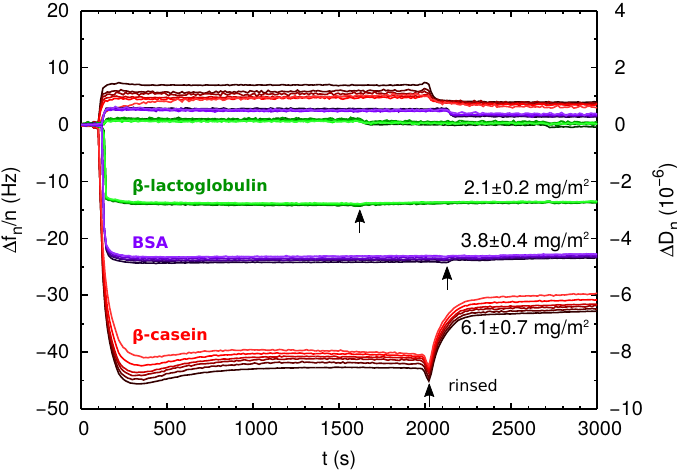
Figure 4. QCM-D measurements for direct adsorption experiments of proteins onto negatively-charged PS hydrophobic surfaces. The curves labeled with the protein names correspond to the changes in resonance frequency ∆ f n / n of the QCM crystal as a function of time due to the addition of 1 mg/mL protein solution. We also show the energy dissipation ∆ D n measured during the same experiments (unlabeled curves). Black arrows indicate the time at which the crystal is rinsed with protein-free buffer solution. The overtones from n = 3 to n = 13 are represented in different tonalities from dark to pale. The adsorbed mass indicated in the figure is obtained using Equation (6) as explained in the main